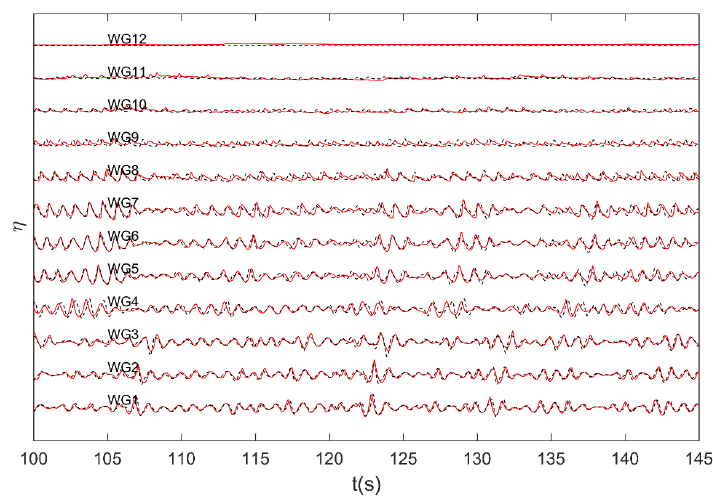
Figure 10. Comparison of the time series of wave surfaces for case 182. Red lines in the figure are measured data and black dashed lines are simulated results. The breaking of random waves upon coral reef terrains is usually accompanied by energy transfer and results in a shift from high-frequency waves to low-frequency waves. Figures 11 and 12 compare the measured and simulated wave energy spectra of four representative wave gauges for two cases. The four wave gauges selected are WG4 positioned off reef deep waters, WG6 on the reef slope, WG8 in the surf zone, and WG11 in the middle of the reef flat. From the figures it can be seen that as waves propagate from deep waters to reef flats, wave energy gradually transfers from spectral peak frequency to both higher and lower frequencies. High-order harmonics are generated at